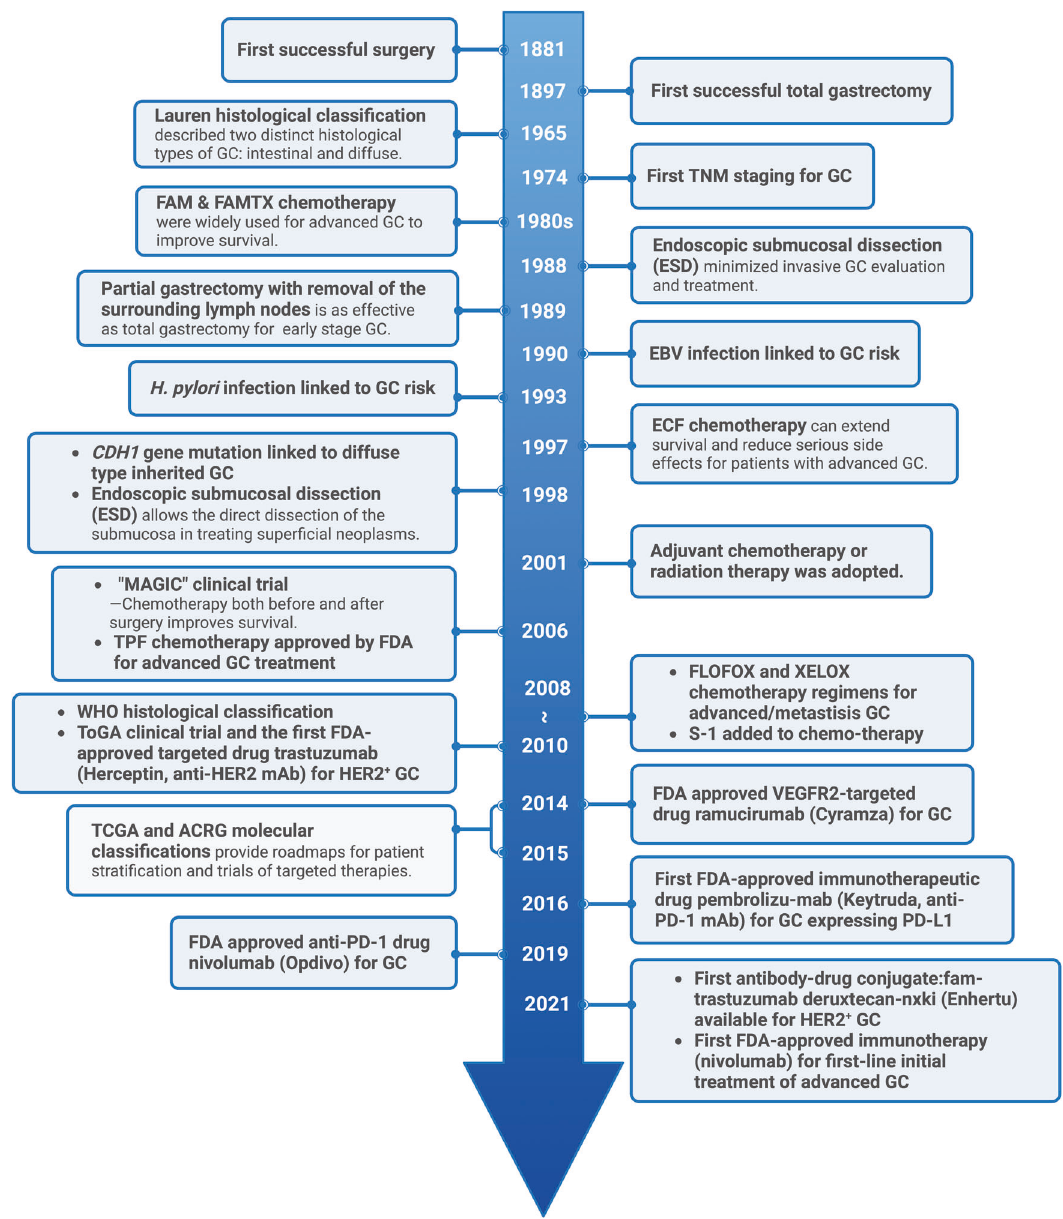
Fig. 1 Timeline of selected key fi ndings and signi fi cant therapy developments in gastric cancer. The major milestones for risk factor identi fi cation, classi fi cation and staging, and therapy developments for GC are listed. Chemotherapy regimens: FAM: fl uorouracil (5- FU) + mitomycin C + doxorubicin; FAMTX: methotrexate + 5-FU + doxorubicin; ECF: epirubicin + cisplatin + 5-FU; TPF: docetaxel + cisplatin + 5-FU; FLOFOX: oxaliplatin + 5-FU + leucovorin; XELOX: capecitabine (Xeloda) + oxaliplatin; S-1: tegafur (5-FU prodrug) + 5-chloro-2,4- dihydroxypyridine (CDHP) + oteracil potassium (Oxo), in a molar ratio of 1:0.4:1. EBV Epstein – Barr virus, TCGAThe Cancer Genome Atlas, ACRG Asian Cancer Research Group. This fi gure was created with